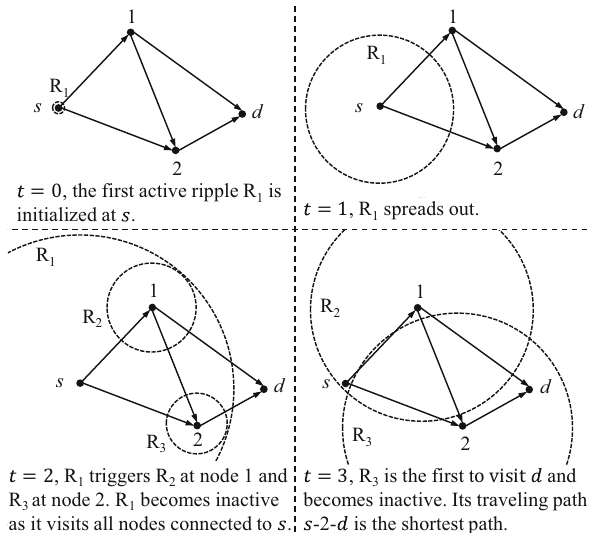
Fig. 4 The illustration of how the RSA solves the